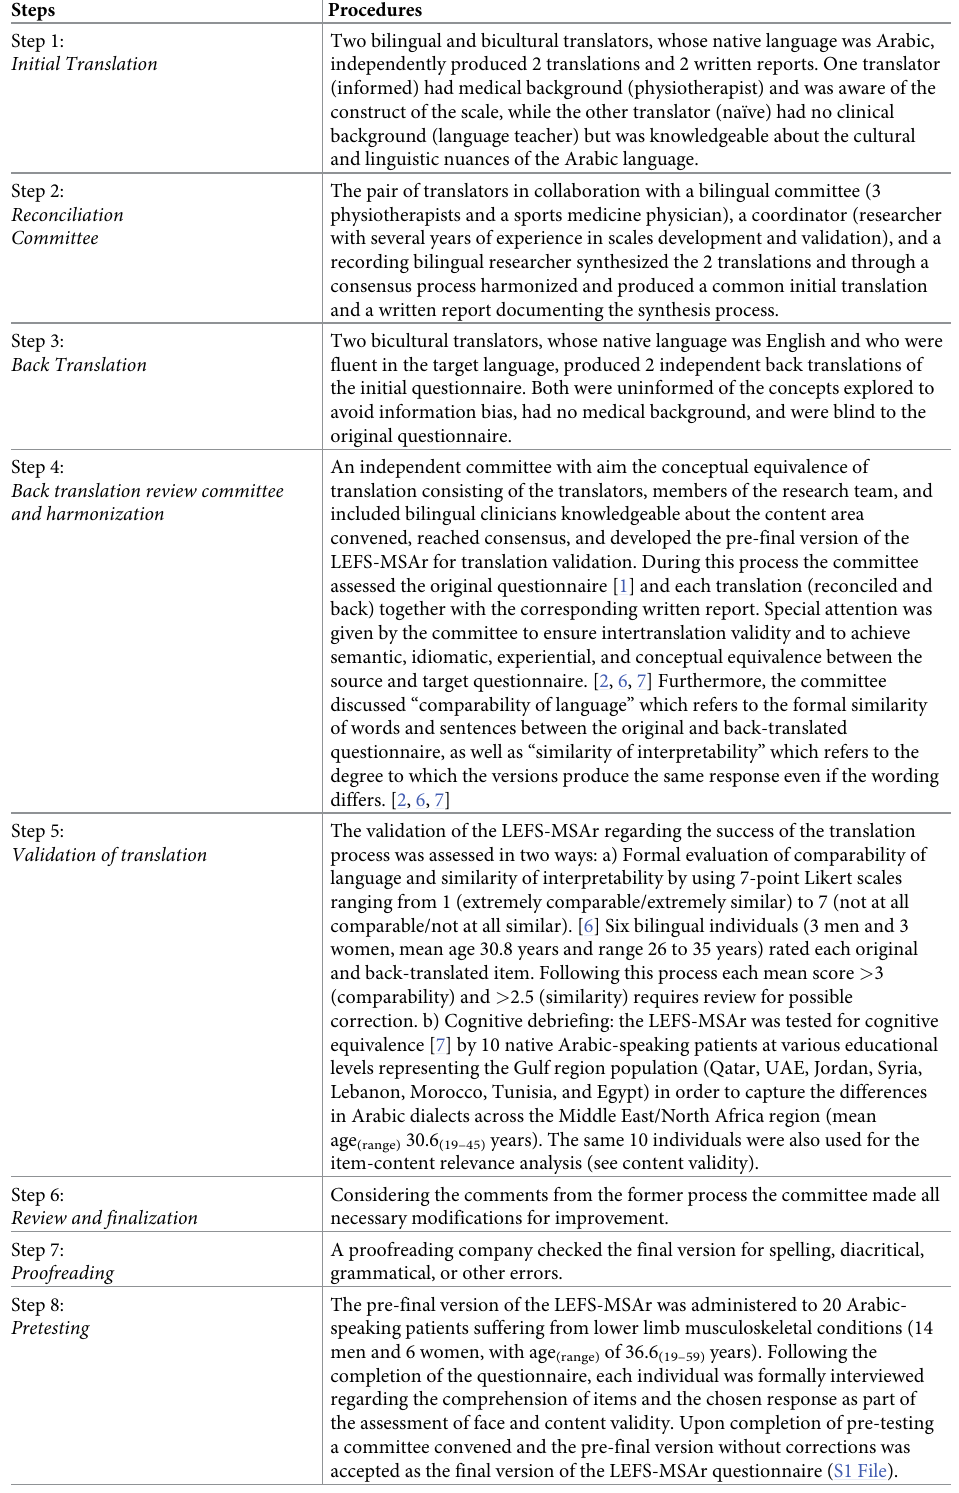
Table 1. The process of translation and cross-cultural adaptation of the LEFS questionnaire for Arabic-speaking